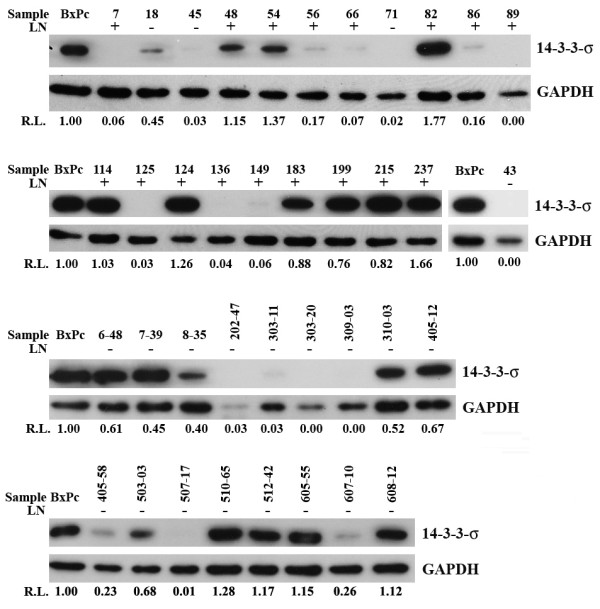
Correlation of 14-3-3σ expression in pancreatic cancer tissues with lymph node metastasis. Thirty-eight fresh frozen human pancreatic ductal adenocarcinoma tissues with (+) or without (-) lymph node (LN) metastasis were analyzed using Western blot for the protein level of 14-3-3σ and GAPDH control. The relative level (R.L.) of 14-3-3σ in each sample was measured and normalized to that of GAPDH. In each gel, lysates from BxPc-3 (BxPc) cells were used as a control and the level of 14-3-3σ in BxPc-3 cells was set to 1.